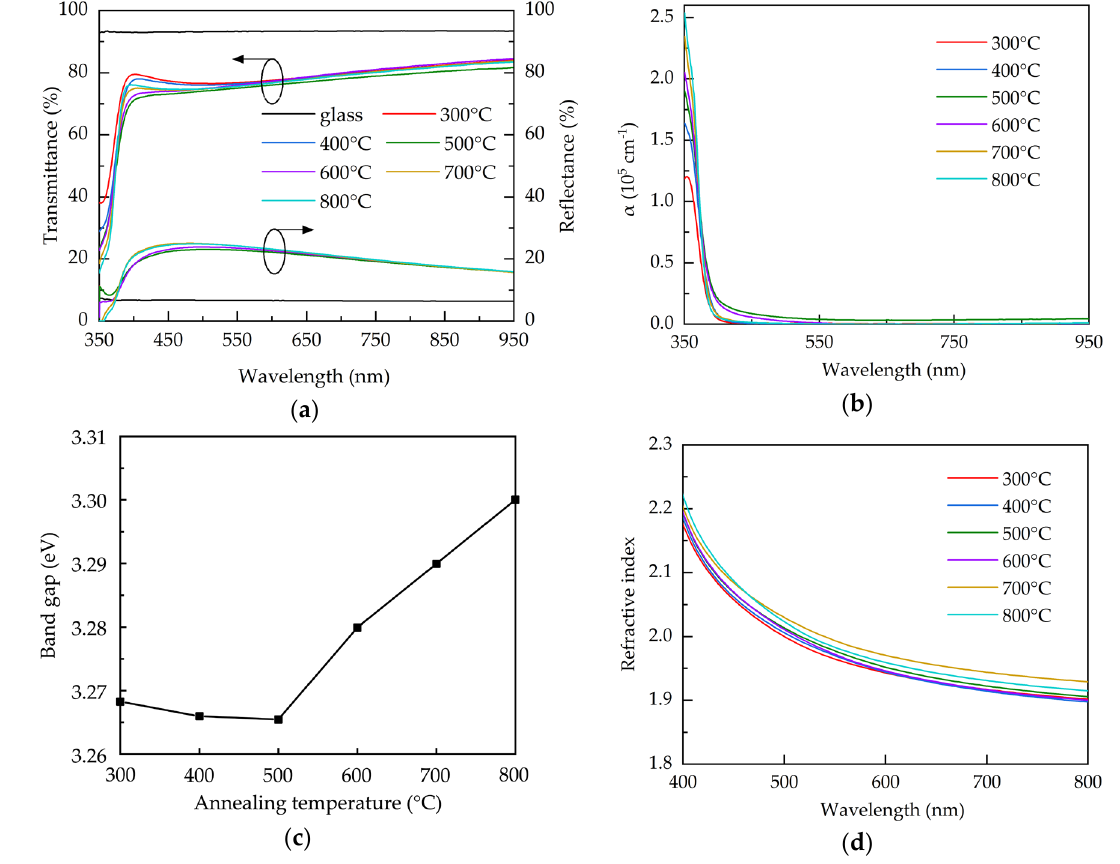
Figure 5. ( a ) Transmittance and reflectance spectra, ( b ) absorption coefficient spectra, ( c ) band gap, and ( d ) refractive index for the AALD Al:ZnO films with different annealing temperature.